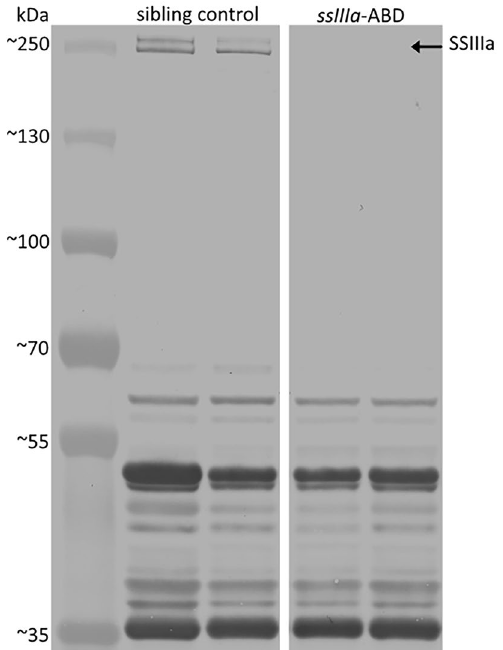
Figure 1. Immunoblot analysis of soluble wheat endosperm extracts separated by SDS-PAGE using maize anti-DU1N antiserum 25 . Soluble endosperm extracts of two sibling control plants and two triple mutant plants (ssIIIa-ABD) were prepared from developing grains 25 days post anthesis. Each lane contained material from 0.2 mg fresh weight of endosperm from separate plants. The leftmost lane was loaded with 5 µl of PageRuler Plus Prestained Protein Ladder (Thermo Scientific). The masses of the marker proteins in kDa are indicated. Different parts of the same blot were used to make this figure; the white space between the blot sections indicates where the image was cropped. The uncropped original blot image is in the Supplementary Material and also includes additional samples from other plants (Figure S3).